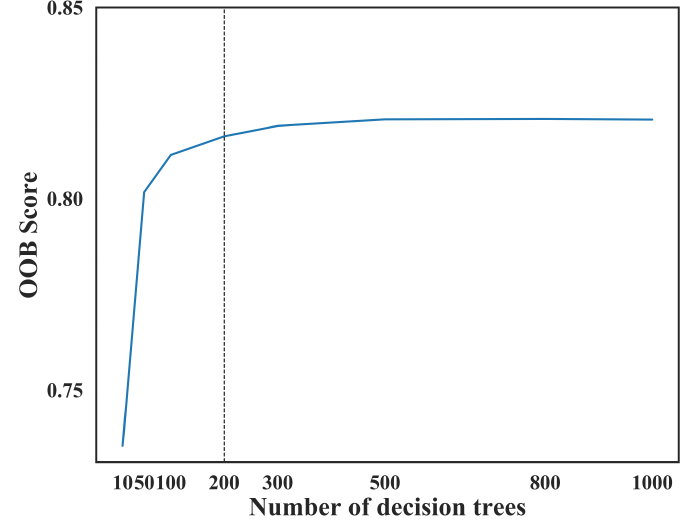
Figure 3. The parameter tuning in the RF model for rain area